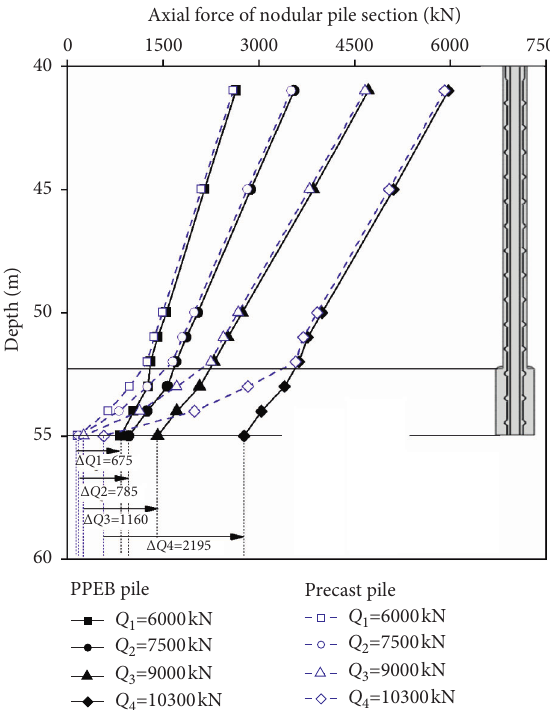
Figure 7: Axial force distribution of the nodular pile section.